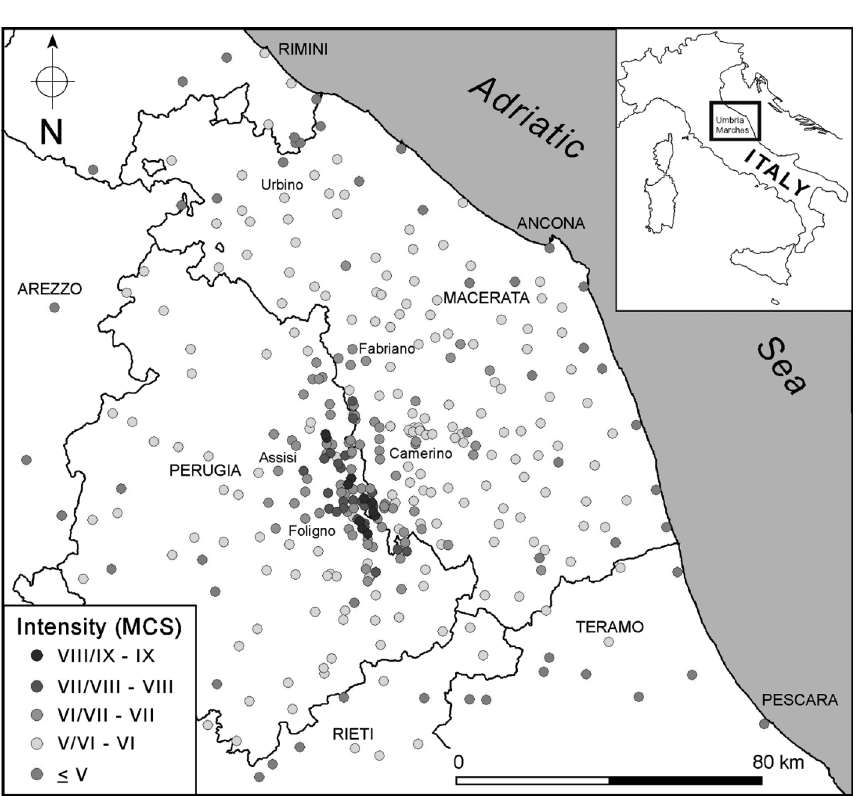
Fig. 1 . Distribution of macroseismic intensities observed of the 26 Semptember 1997 earthquake and follow- ing days (Monachesi et al. , 1997; update 7 October